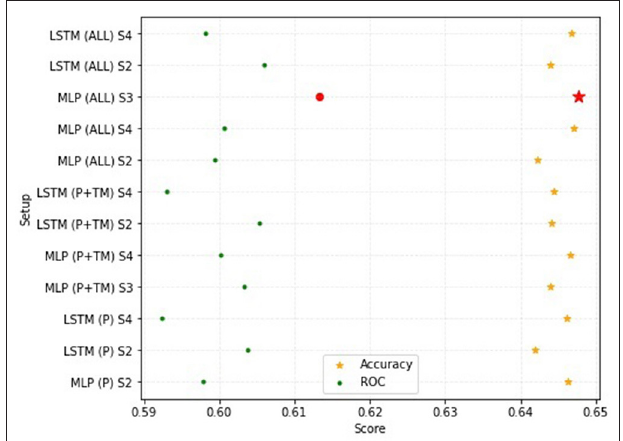
FIGURE 7 | Performance comparison for the ROC and accuracy measures using different subsets of the FDV event sequence dataset; P refers to the fixed field data, TM refers to the text mining data and ALL refers to the fixed field, text mined and NSW Health dataset; S refers to the setup number for each deep learning